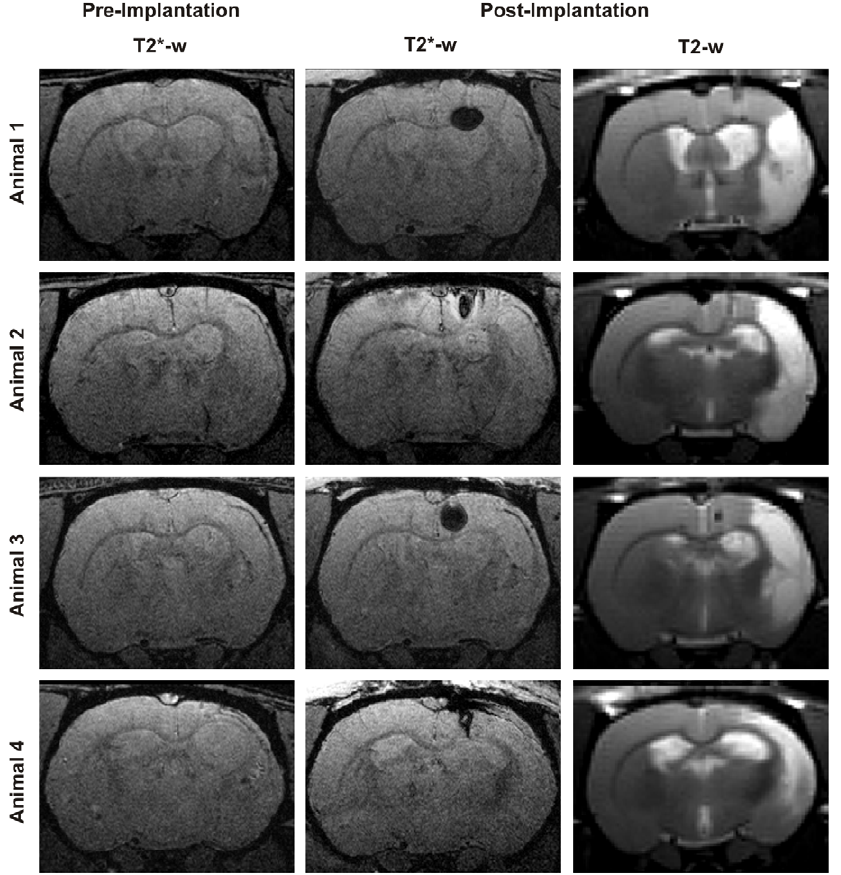
Figure 3. Localization of labeled cells by T2*-weighted MRI. 3D high resolution T2*-weighted MR images, pre- (1st column) and post- (2nd column) implantation of USPIO-labeled stem cells, showing the successful implantation of the cells into the brain parenchyma. Corresponding T2- weighted images (3 rd column) confirm that cells were implanted in healthy tissue.